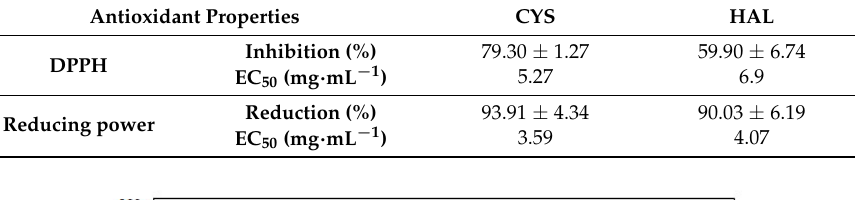
Table 1. Antioxidant properties of CYS and HAL aqueous extracts.